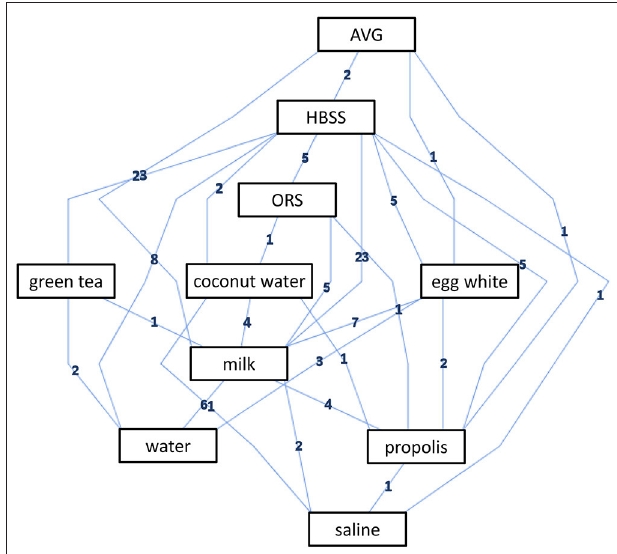
FIGURE 2 | Evidence structure of cell